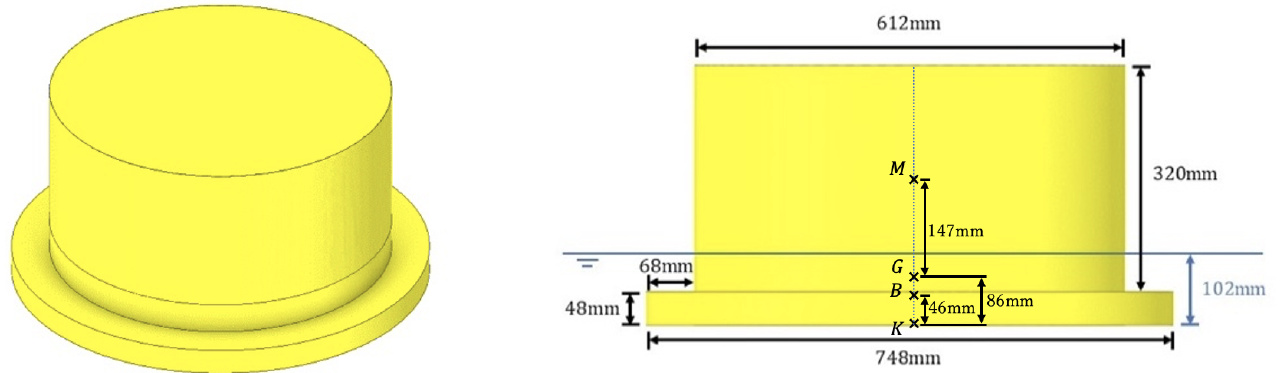
Figure 2. Dimensions of the reduced-scale model of the